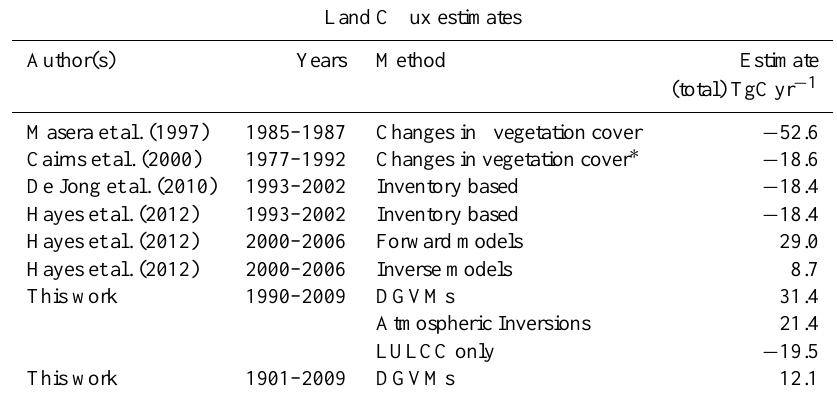
Table 1. Different estimates for the land C-flux of the country. A negative sign indicates a source to the atmosphere and a positive sign a sink.